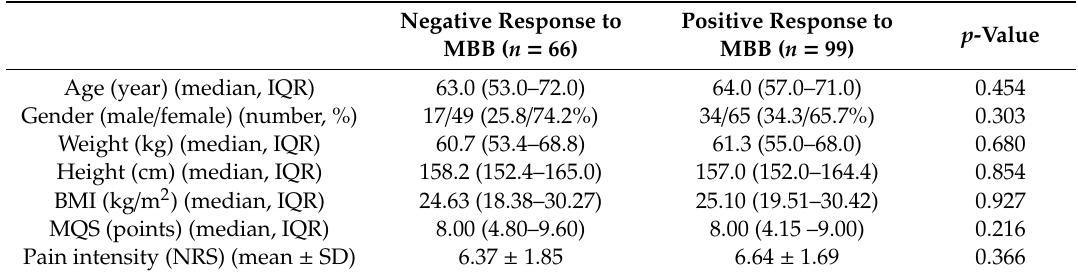
Table 1. Baseline characteristics of the